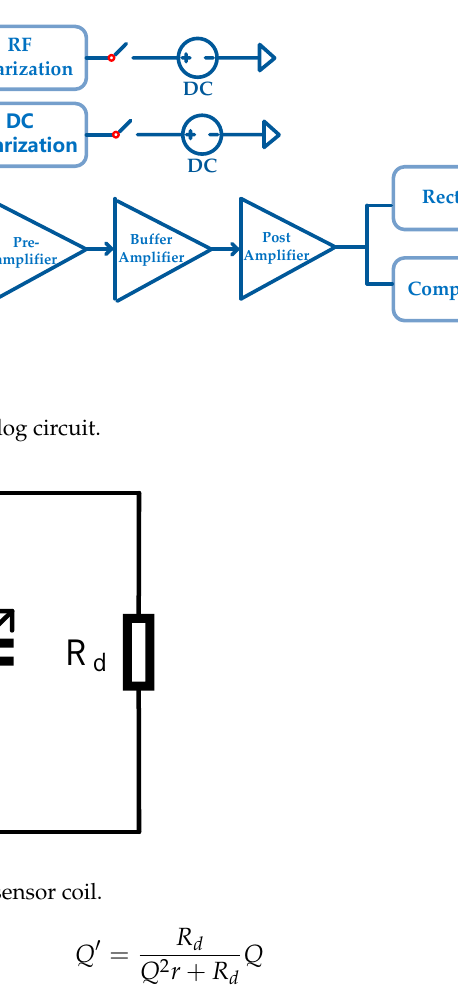
( b ) Figure 9. MAXWELL simulation of low-frequency coil ( a ) and axial magnetic field intensity distri- bution ( b ). The design of the sensor geometry is mainly considered to be as small as possible for obtaining a high gradient tolerance; excessive coil turns will lead to extremely large in- ductance, which will reduce coil bandwidth and portability; the decrease in coil turns is accompanied by the decrease in signal; extremely thick wire diameter indicates extremely large volume and loss of portability; extremely small wire diameter leads to extremely large resistance, thereby increasing the thermal noise of the sensor. Considering the geo- metric size, gradient tolerance, coil bandwidth, signal amplitude, and sensor noise, the resultant number of turns is 700; the wire gauge is 0.53 mm; the resistance is 22 Ω; the inductance is 35 mH; and the self resonant frequency is approximately 47 kHz after shield- ing. As shown in Figure 9b, the maximum value of the DC polarization field is designed